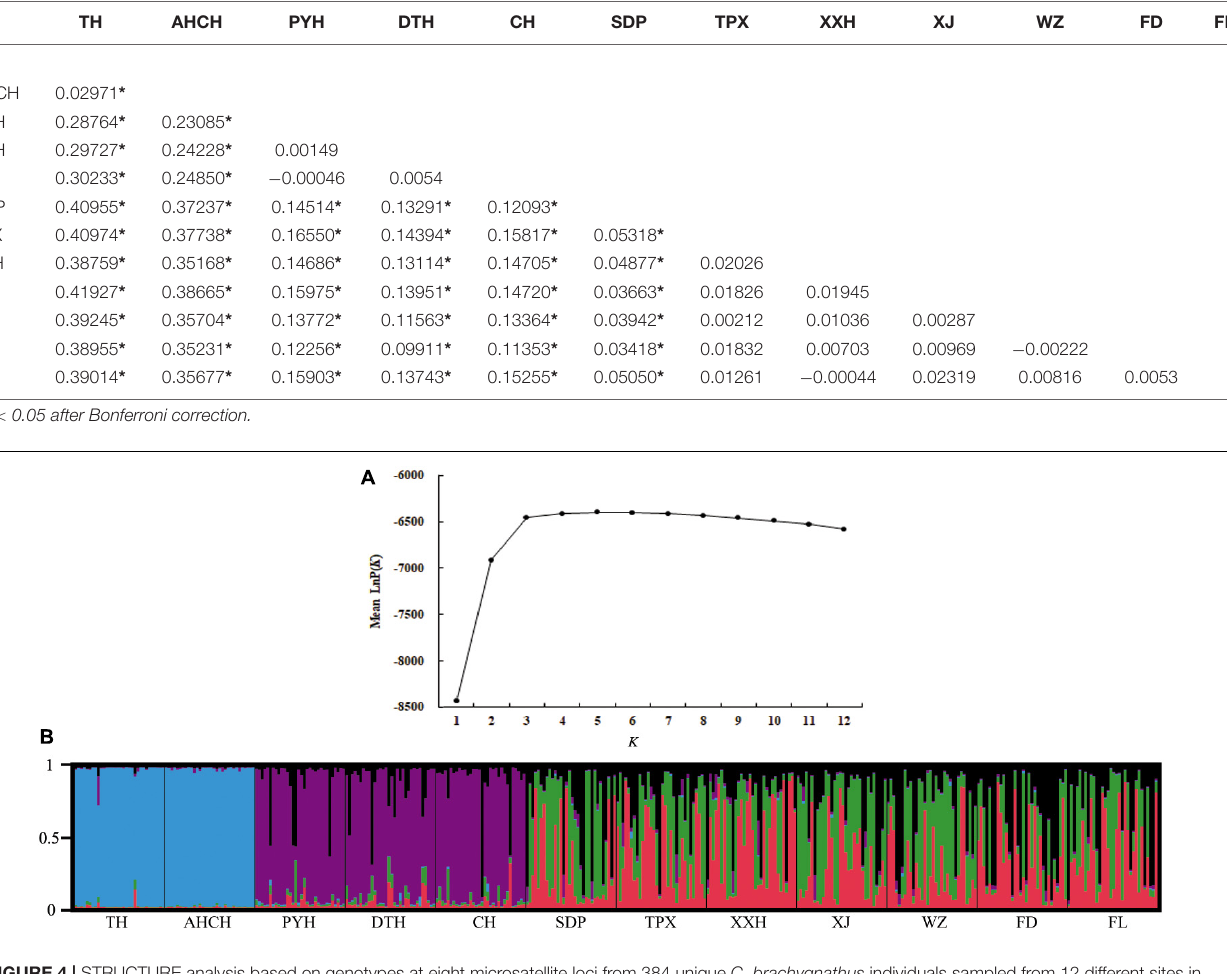
geographic distance and the dispersal ability of C. brachygnathus (Radinger and Wolter, 2014; Radinger et al., 2017). Due to limited diffusion capacity, C. brachygnathus in the middle reaches of the Yangtze River can spread to the Three Gorges Reservoir, while C. brachygnathus in the lower Yangtze River hardly spread to the Three Gorges